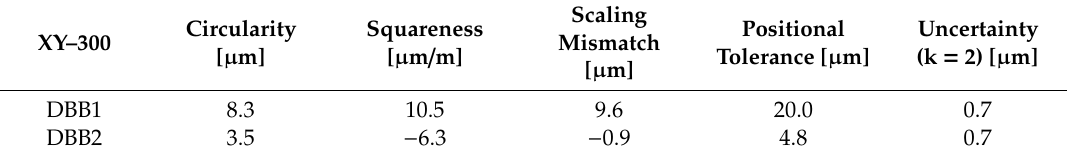
Figure 9. Circularity test—200 mm diameter: ( a ) without volumetric compensation; ( b ) with volumetric compensation. Table 9. Results of the circularity test—200 mm diameter.